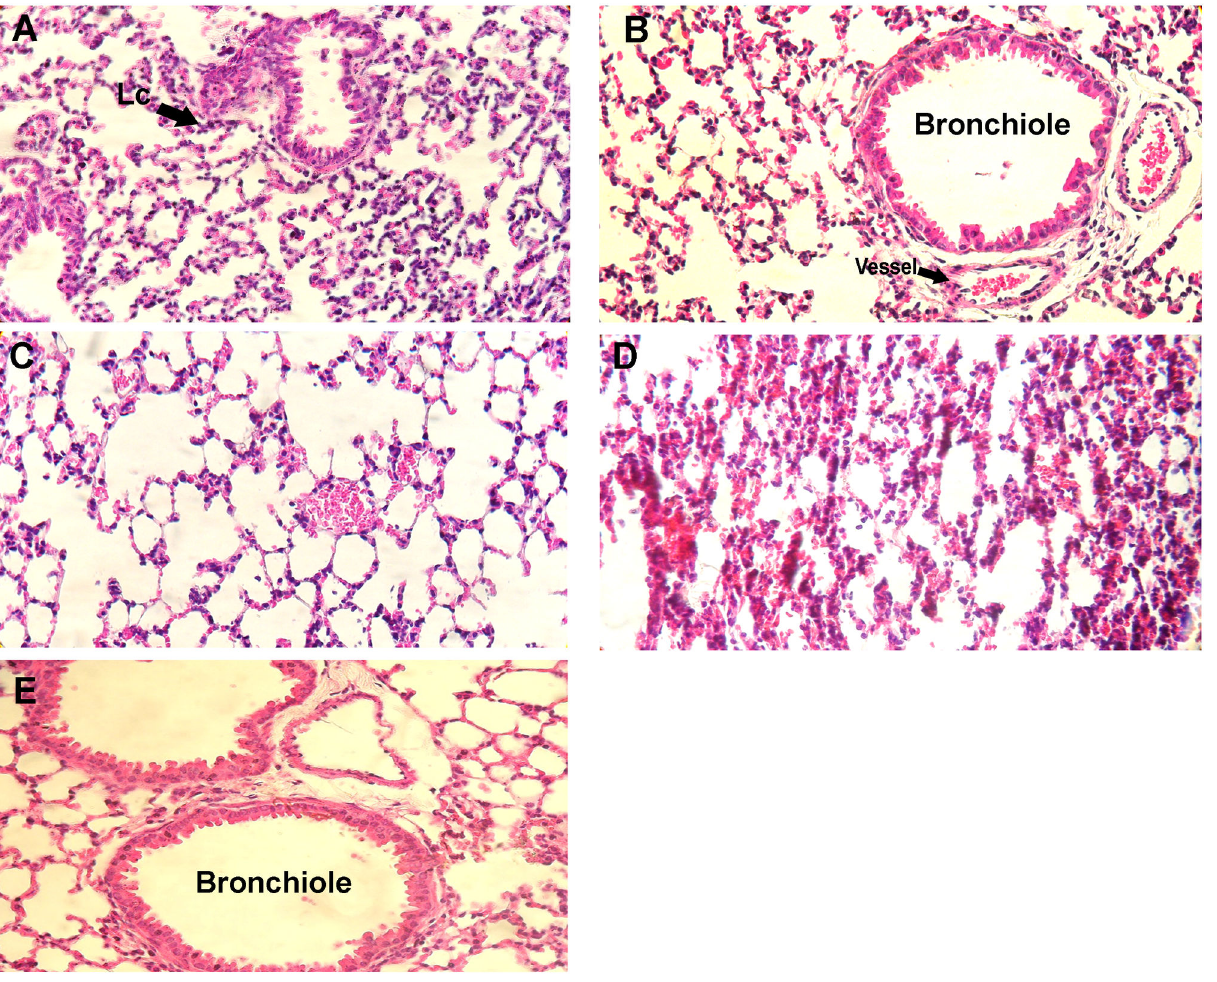
Figure 8. The effect of the aqueous seed extract on the infiltration of polymorphonuclear leukocytes into the lungs of mice with carrageenan-induced pleurisy. The histological sections were stained with hematoxylin-eosin (x 400). (A) Inflammation in the mice treated with carrageenan. (B) Reduction of the presence of PMN in the mice previously treated with the aqueous seed extract at 500 mg/kg. (C) Reduction of the presence of PMN in the mice that were previously treated with the aqueous seed extract at 250 mg/kg. (D) Extensive infiltration of PMN in the mice that were previously treated with the aqueous seed extract at 125 mg/Kg. (E) Normal mouse lung tissue. Lc = Leukocyte. doi: